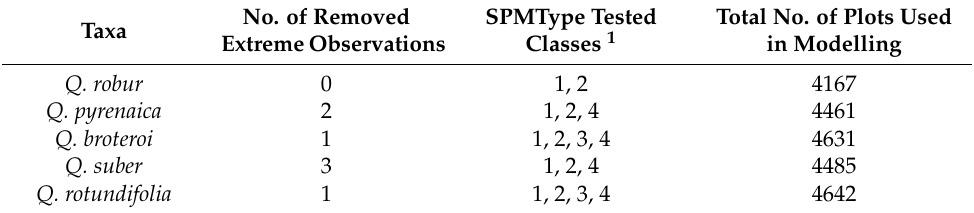
Table 2. SPMType tested classes for each taxon and total no. of plots used in modelling. No. of Removed SPMType Tested Total No. of Plots Used Taxa Extreme Observations Classes 1 in Modelling Q. robur 0 1, 2 4167 Q. pyrenaica 2 1, 2, 4 4461 1 1, 2, 3, 4